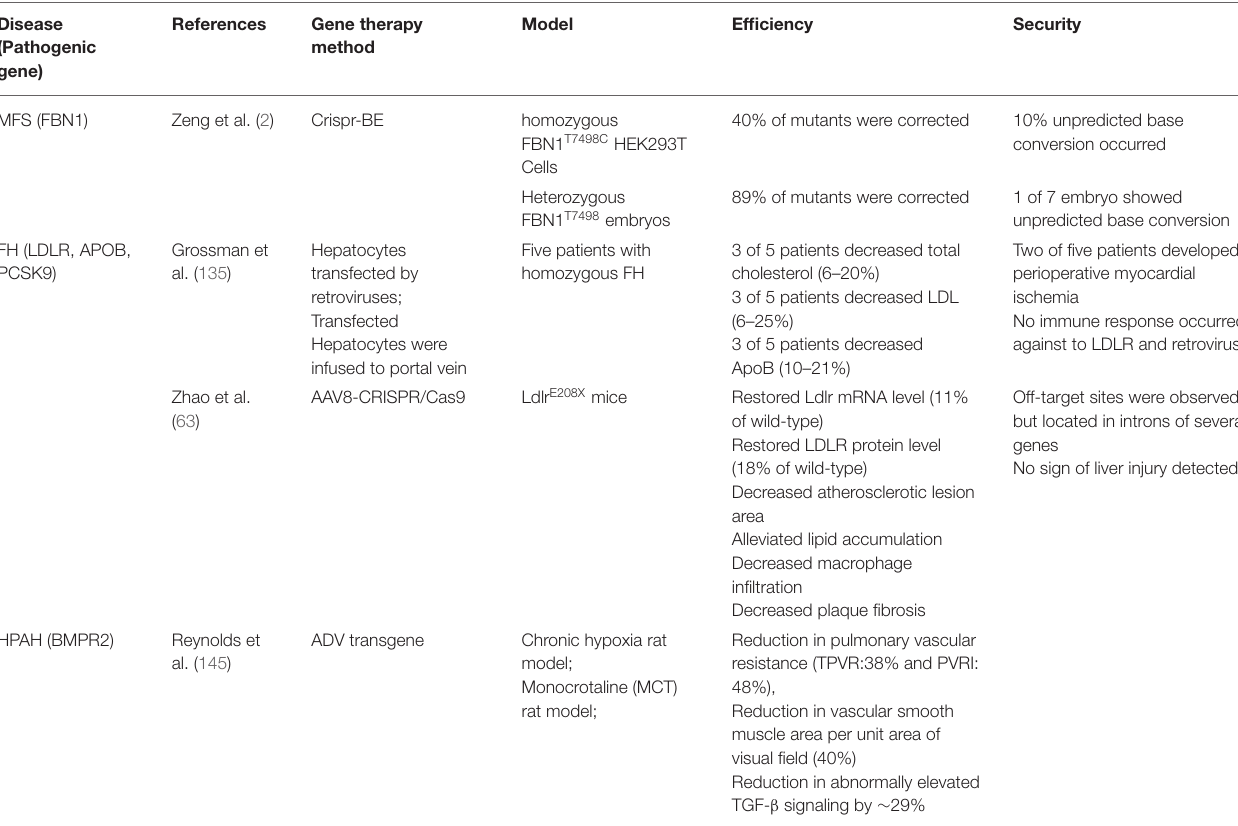
TABLE 3 | Experiments of gene therapy for hereditary cardiovascular diseases. Disease (Pathogenic